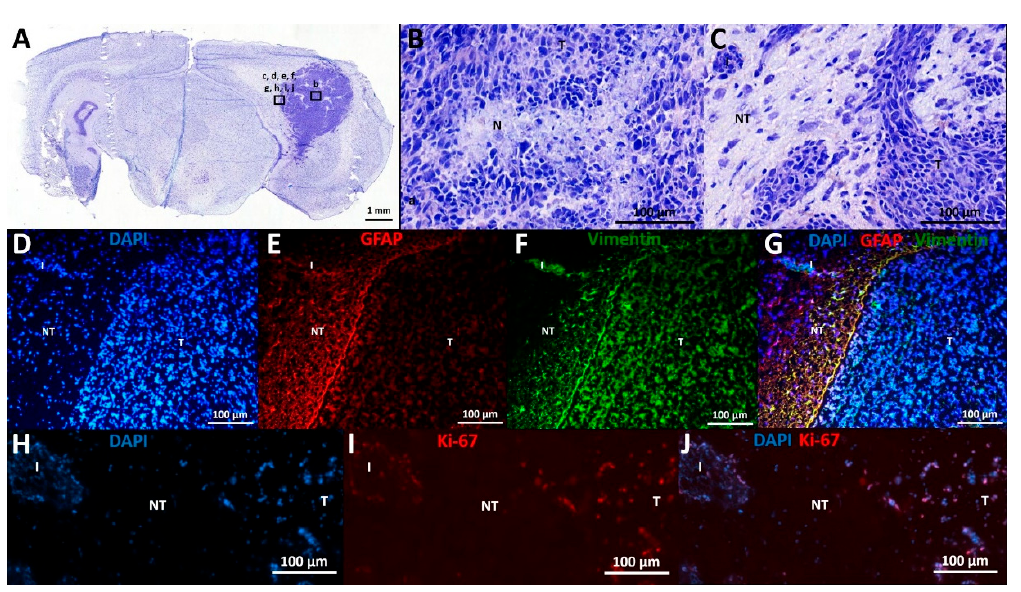
Figure 3. Histological and immunohistochemical analysis. ( A–C ) Cresyl violet staining: ( A ) This overview picture shows a tumor-containing coronal slice stained with cresyl violet. Tumor tissue can be clearly identified on the right of the slice, appearing dark purple as opposed to less intense stained normal brain tissue. ( B ) Cresyl violet staining in tumor tissue, 20× magnification: This figure shows a necrotic spot surrounded by palisading tumor cells (N), as well as nuclear atypia and marked hypercellularity. ( C ) Cresyl violet staining at tumor border, 20× magnification: This figure shows the transition from tumor (T) to non-tumor (NT) tissue, including an infiltrative spot (I). ( D–G ) Expression of GFAP and vimentin: ( D ) DAPI staining: Tumor tissue contains more densely packed cells compared to neighboring non-tumor tissue, as demonstrated by DAPI positive nuclei. ( E ) GFAP staining: GFAP labeling is mainly found at tumor border and di ff use in tumor tissue. ( F ) Vimentin staining: Vimentin labeling is found at tumor border and di ff use in tumor tissue. ( G ) DAPI, vimentin, and GFAP overlay: Many double positive cells align at tumor border. ( H – J ) Expression of Ki-67: ( H ) DAPI staining. ( I ): Ki-67 staining. ( J ): DAPI and Ki-67 overlay: Ki-67 positive cells are seen in tumor tissue and infiltrative spots, whereas most cells in adjacent non-tumor tissue are Ki-67 negative. T—tumor